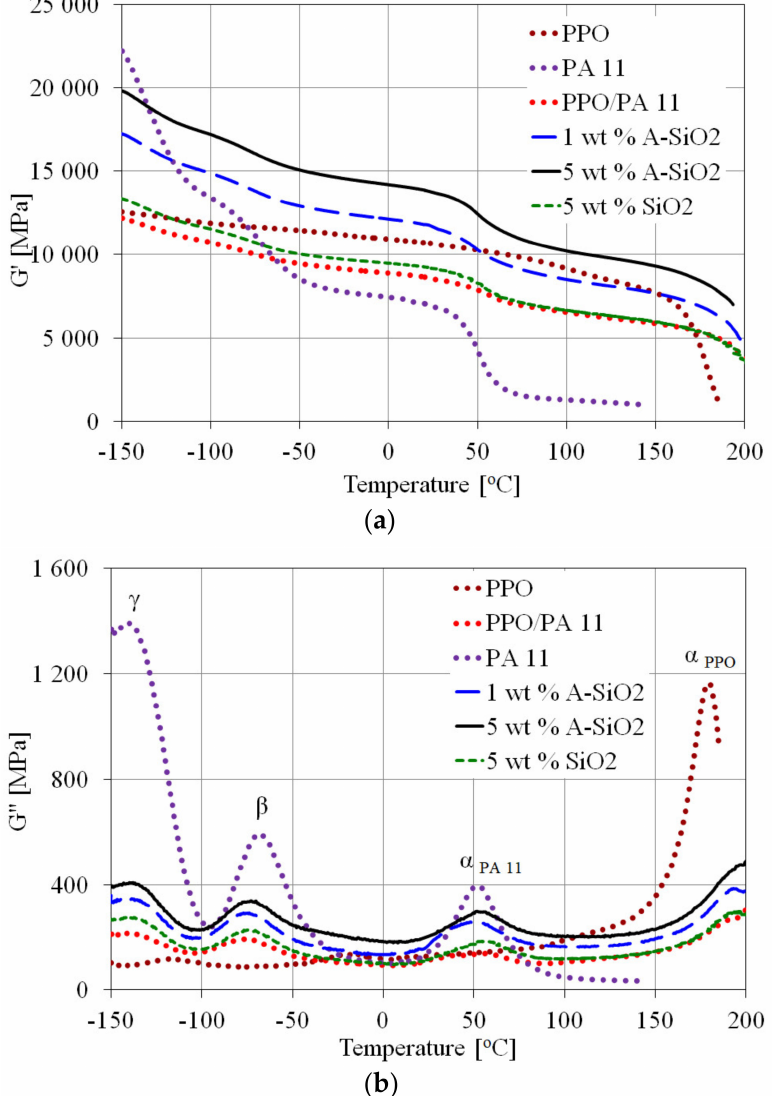
Figure 8. Storage moduli G (cid:48) ( a ) and loss moduli G (cid:48) ( b ) of PPO, PA11, and PPO/PA11/silica compos- ites as functions of